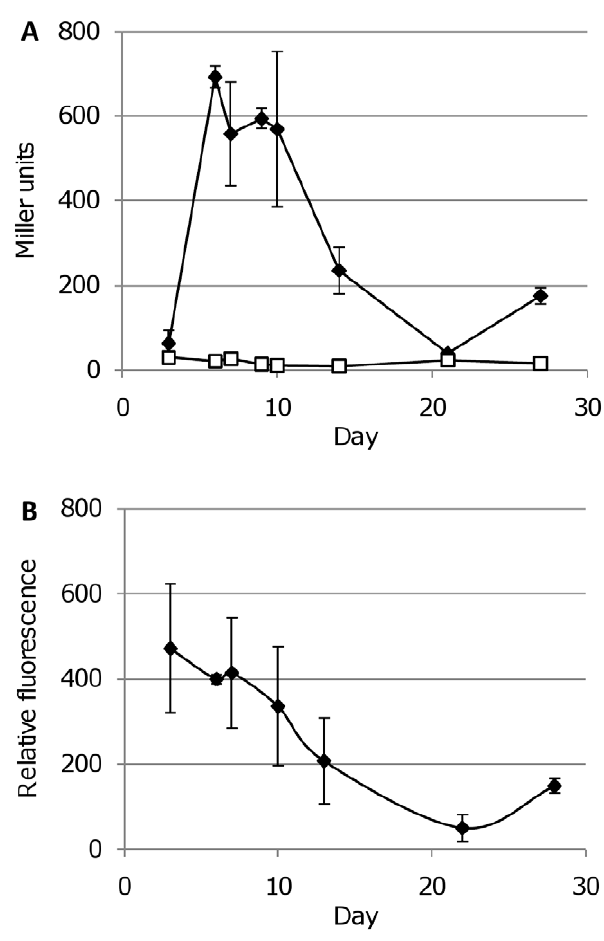
Figure 14. M.tuberculosis P mbtB activity during hypoxic culture. Promoter activity was assayed in the hypoxia model using (A) LacZ and (B) mCherry as a reporter. Activity of LacZ is reported in Miller units (units activity per mg total protein in cell-free extracts). Activity from mCherry is reported in relative fluorescence units (fluorescence after background subtraction per OD 580 in whole cells). (A) & P mbtB activity; % control vector pSM128 activity. (B) ¤ P mbtB activity.